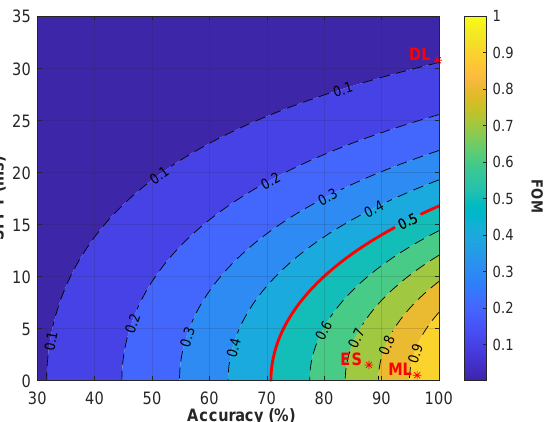
Figure 8. FOM heatmap for different values of A and SFPT. Red stars * indicate the score of selected approaches from each category.